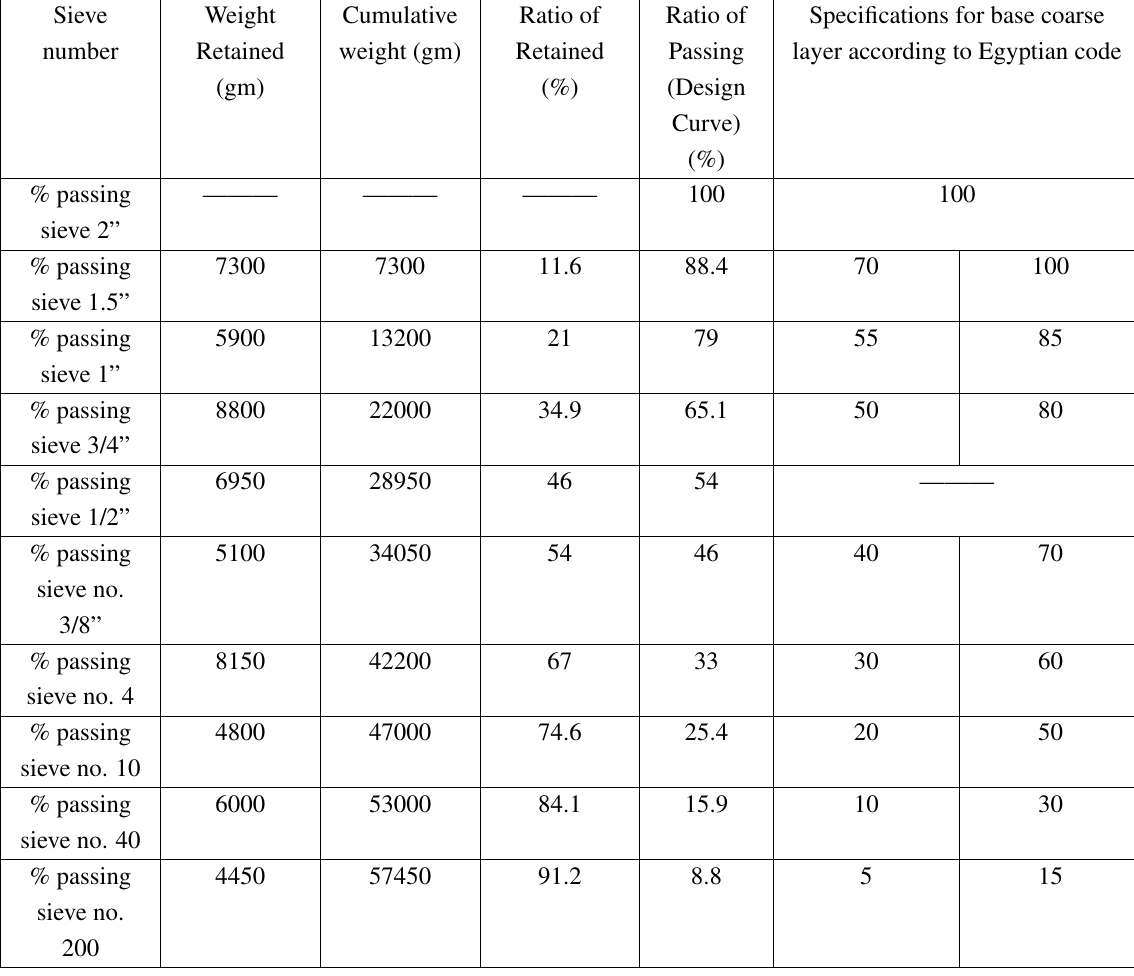
Table 1. Accepted percentage of passing forstandard mix due to Sieve analysis for aggregates used in base course mixture